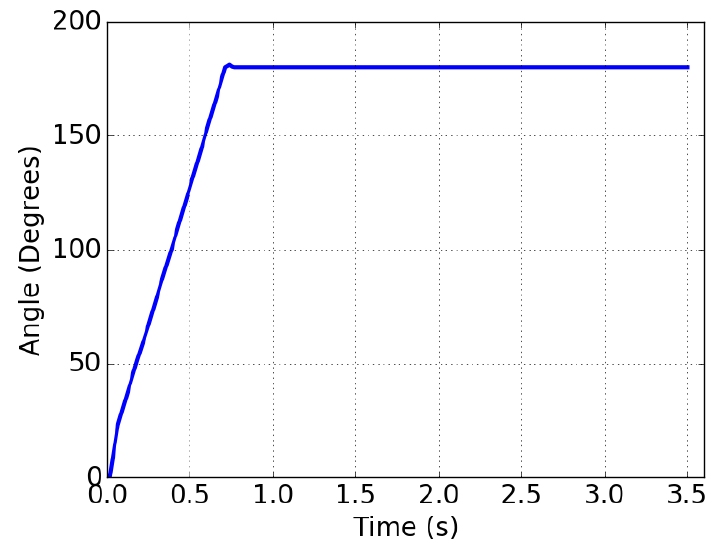
Figure 11. Response of the servomotor when the stimulus is changed from 0° to 180° at t = 0. It can be seen how there is an overshoot of 2° . The servomotor reached the set-point position.